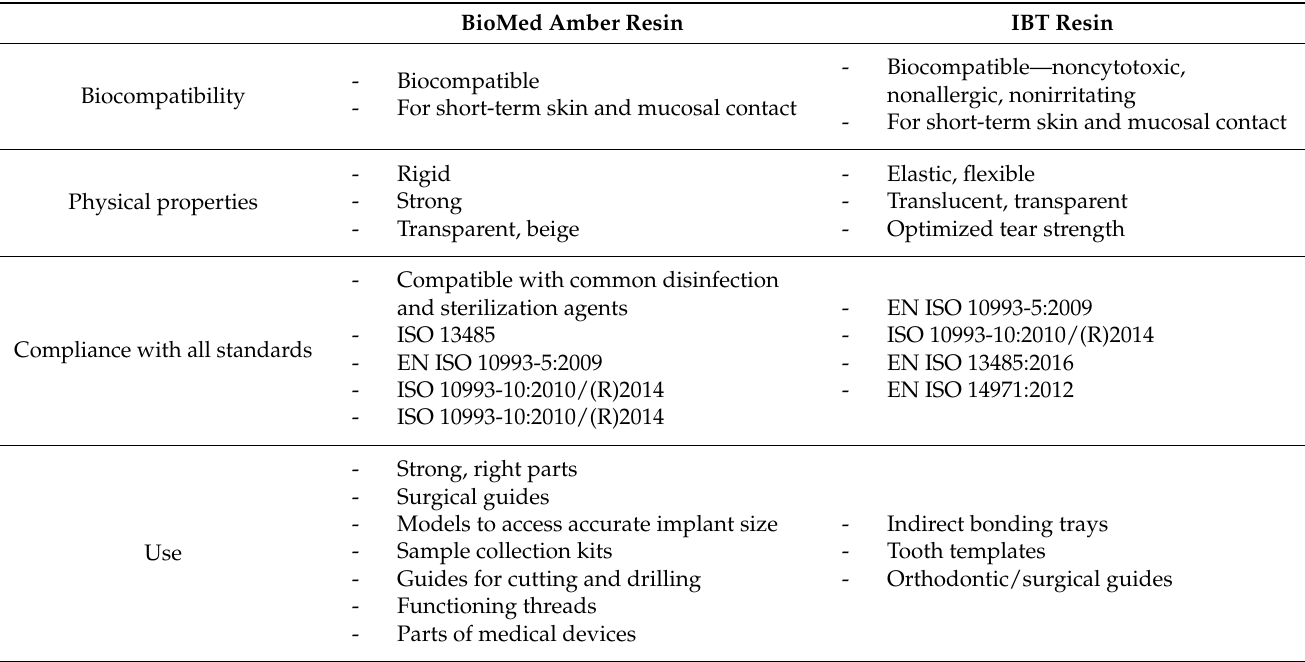
Table 1. Properties of BioMed Amber and IBT resins (according to the producer). BioMed Amber